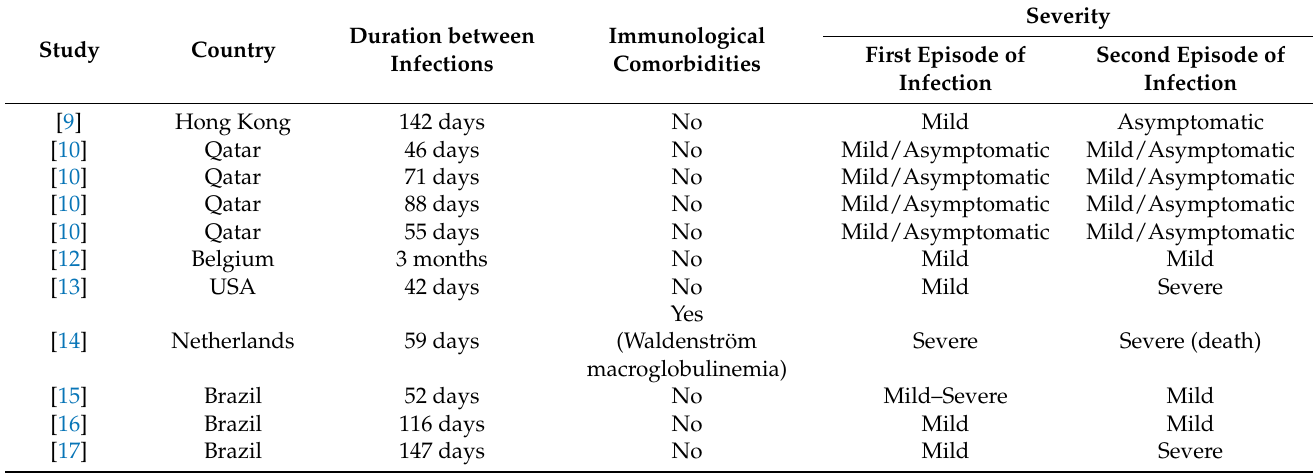
Table 1. Brief summary of some SARS-CoV-2 reinfection